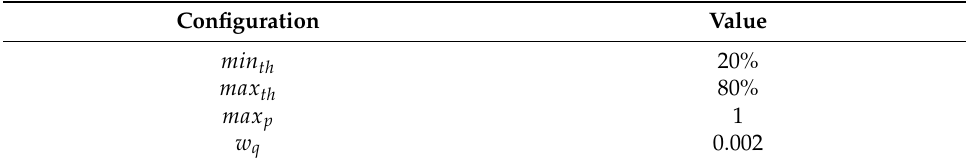
Table 4. BLUE configuration.